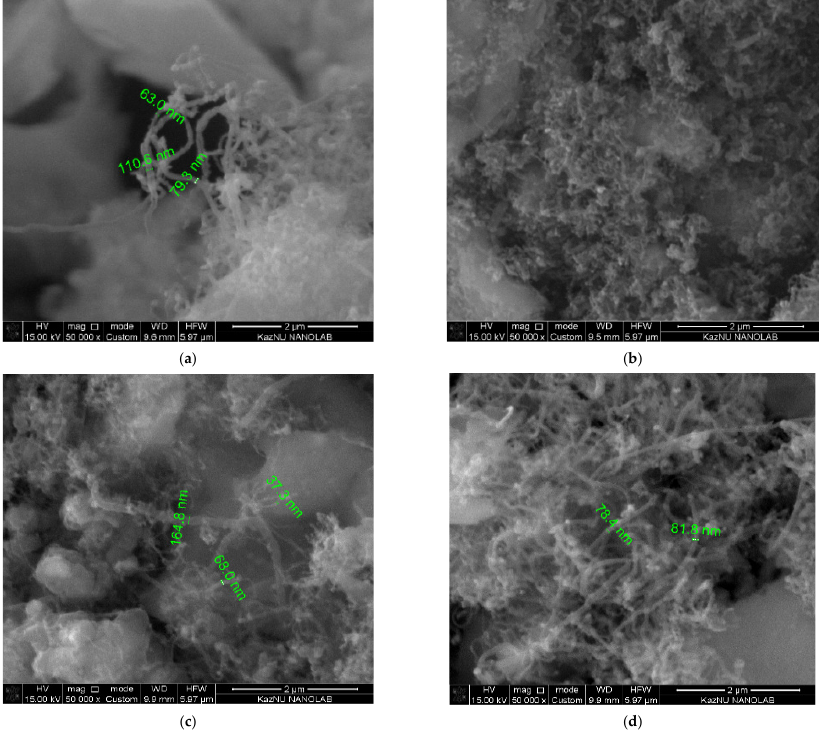
Figure 10. SEM images of MWCNTs. ( a ) T = 750 °C: at (1.5 M; Ni(NO 3 ) 2 ·6H 2 O); ( b ) T = 800 °C: at (1.5 M; Ni(NO 3 ) 2 ·6H 2 O); ( c ) T = 750 °C: at (1.5 M; C о Cl 2 ·6H 2 O); ( d ) T = 800 °C: at (1.5 M; C о Cl 2 ·6H 2 O).